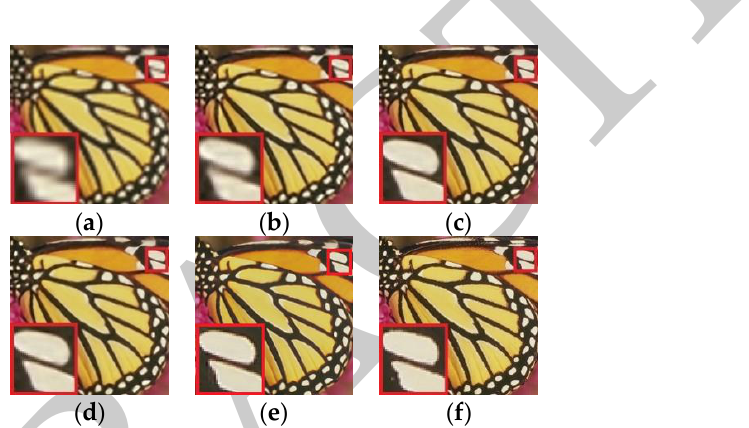
Figure 5. Super-resolution reconstruction results of the image “Butterfly” with “ × 4” scale factor. ( a ) Bicubic [5]; ( b ) A+ [11]; ( c ) SRCNN [18]; ( d ) EEDS [20]; ( e ) The Proposed Method’s ; ( f ) Original Image.